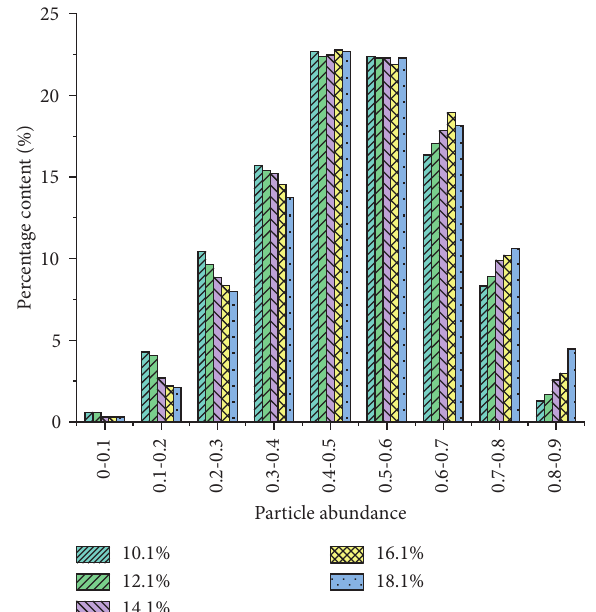
Figure 11: Abundance percentage content of remolded soil